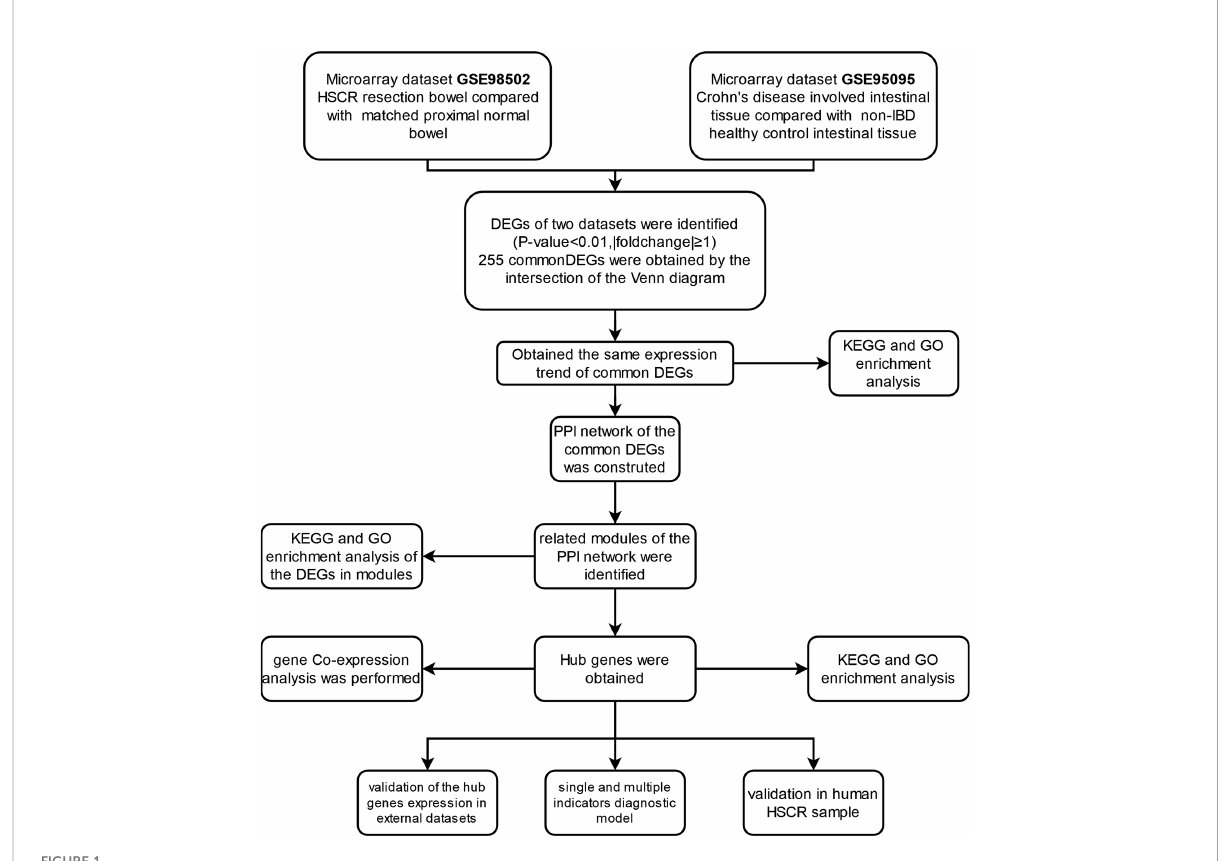
FIGURE 1 Research design fl